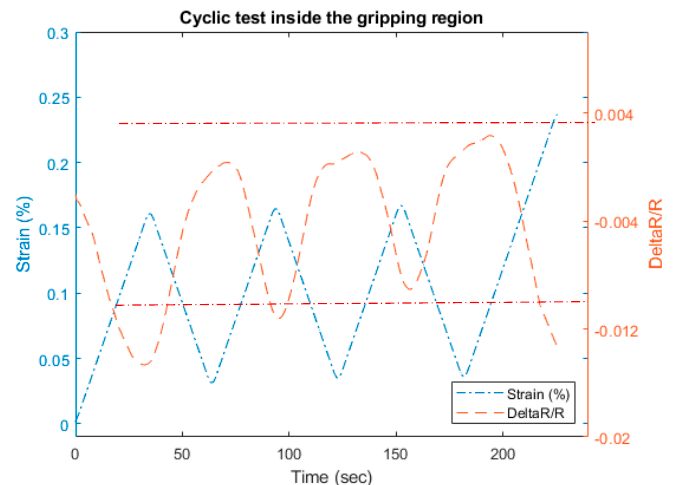
Figure 13. Cyclic test outside the gripping region with hysteresis behavior.